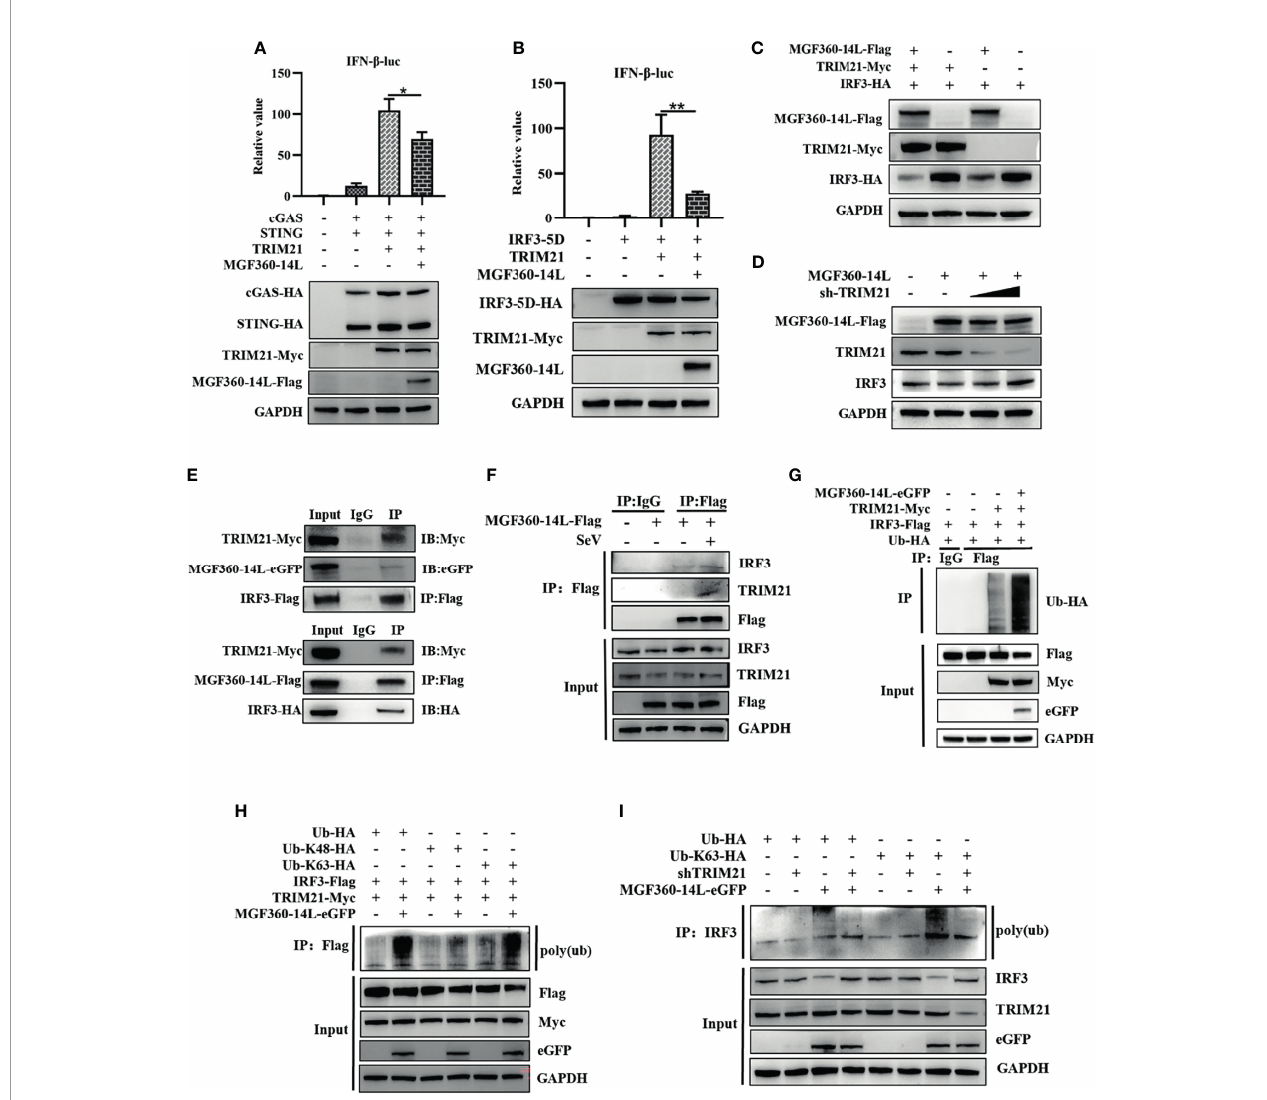
FIGURE 4 | MGF360-14L destabilizes IRF3. (A, B) HEK293T cells were co-transfected with IFN- b -luc (20 ng), pRL-TK (2 ng), cGAS (10 ng), STING (40 ng) or IRF3- 5D-HA (50 ng), MGF360-14L-Flag (50 ng), and TRIM21-HA (50 ng) or empty plasmid. At 24 h post-transfection, cells were treated and analyzed using dual-luciferase reporter assays. (C) HEK293T cells were transfected with MGF360-14L-Flag (500 ng), TRIM21-Myc (500 ng), IRF3-HA (500 ng) or empty plasmids. (D) HEK293Tcells were transfected with MGF360-14L-Flag (500 ng), sh-TRIM21 (500 ng,1000 ng) or empty plasmid. (E) HEK293T cells were transfected with MGF360-14L-eGFP (or MGF360-14L-Flag), TRIM21-Myc and IRF3-Flag (or IRF3-HA) plasmids. (F) HEK293T cells were transfected with MGF360-14L-Flag plasmids for 18h and then incubated with SeV (1MOI) for 6 h. The cells were lysed, and subjected to IP using anti-Flag or control IgG. Precipitates were analyzed by WB. (G, H) IP with anti-Flag beads analysis of lysates of HEK293T cells transfected with Ub-HA, or Ub-K48-HA, or Ub-K63-HA, TRIM21-Myc, MGF360-14L-eGFP and IRF3-Flag for 24h. (I) IP with anti- IRF3 beads analysis of lysates of HEK293T cells transfected with Ub-HA, or Ub-K63-HA, shTRIM21 and MGF360-14L-eGFP for 24h. Expression of MGF360-14L-Flag (or MGF360-14L-eGFP), TRM21-Myc (or TRIM21-HA), IRF3-HA (or IRF3-Flag),Ub-HA, Ub-K48-HA, Ub-K63-HA and GAPDH were assessed by Western blot analysis. Data shown are the mean ± SEM; *p < 0.001, **p < 0.001. Representative results are from at least three independent